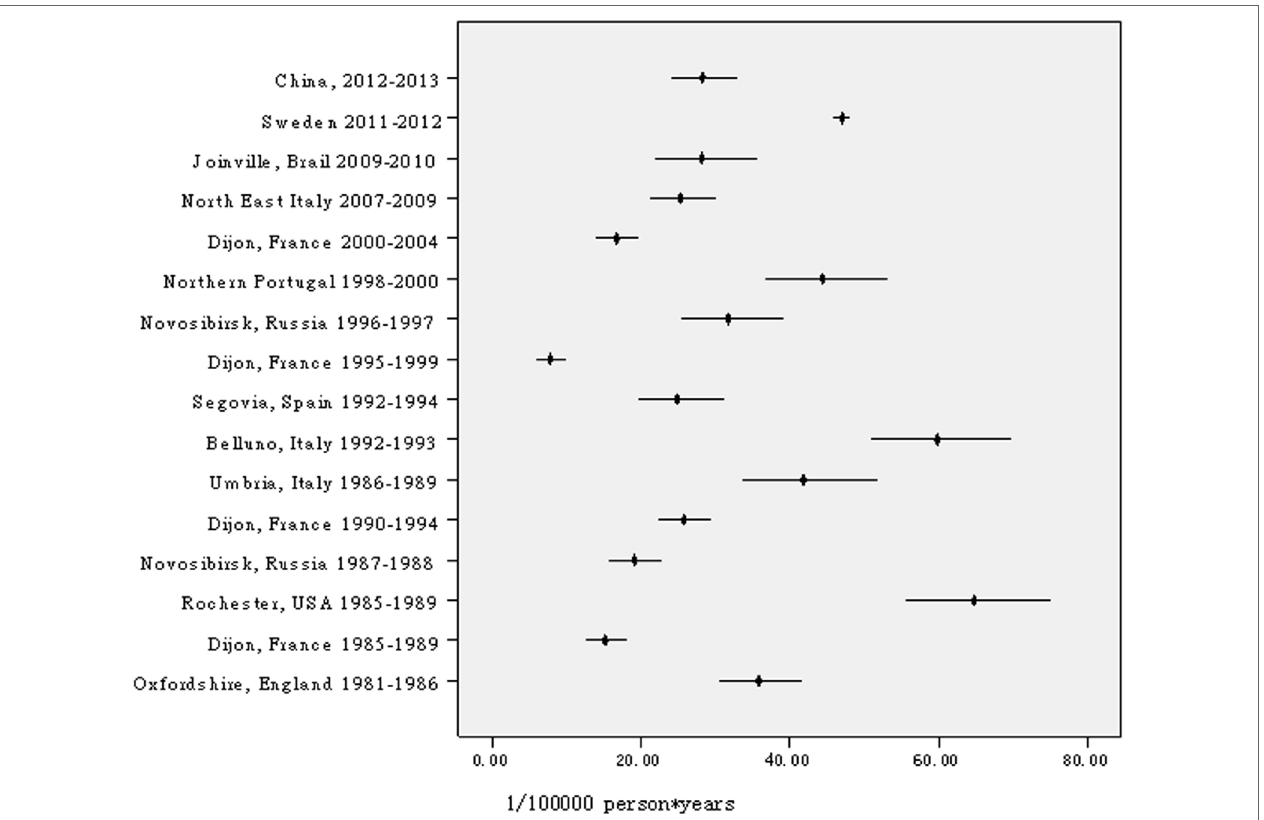
FigUre 4 | Annual incidence of transient ischemic attack per 100,000 people per year in different all-age populations, age standardized to the European